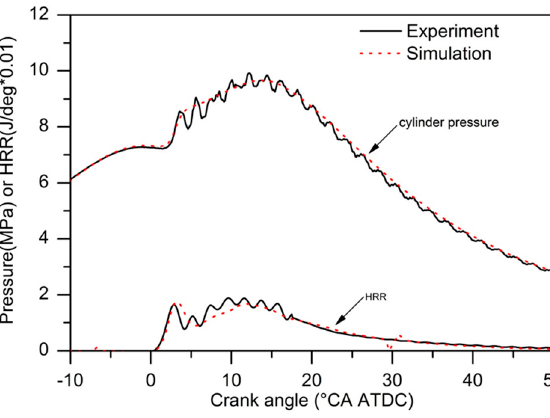
Figure 4. Comparison of in-cylinder pressure and heat release rate versus crank angle between simulation and experiment results.